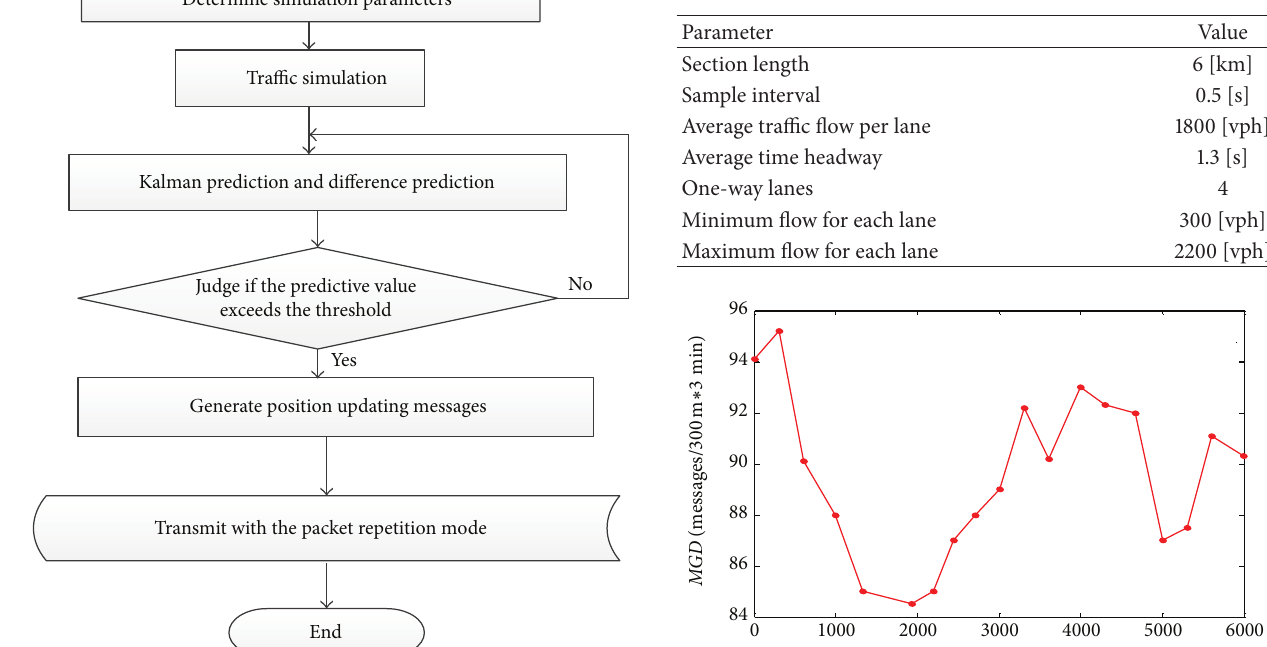
Table 1: Simulation parameters on eight-lane highway basic section.